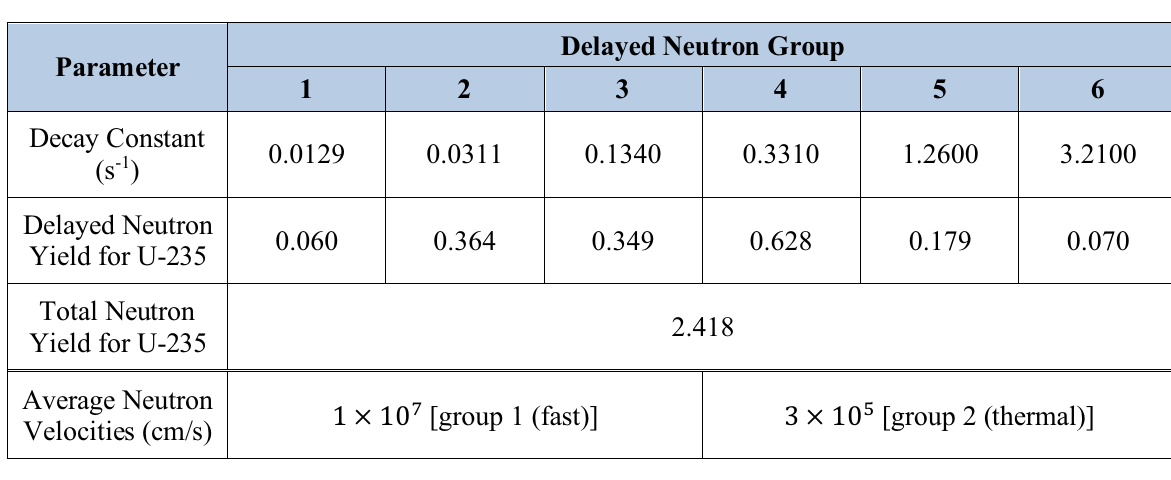
Table III. Kinetics Parameters (Refs. [5-7])